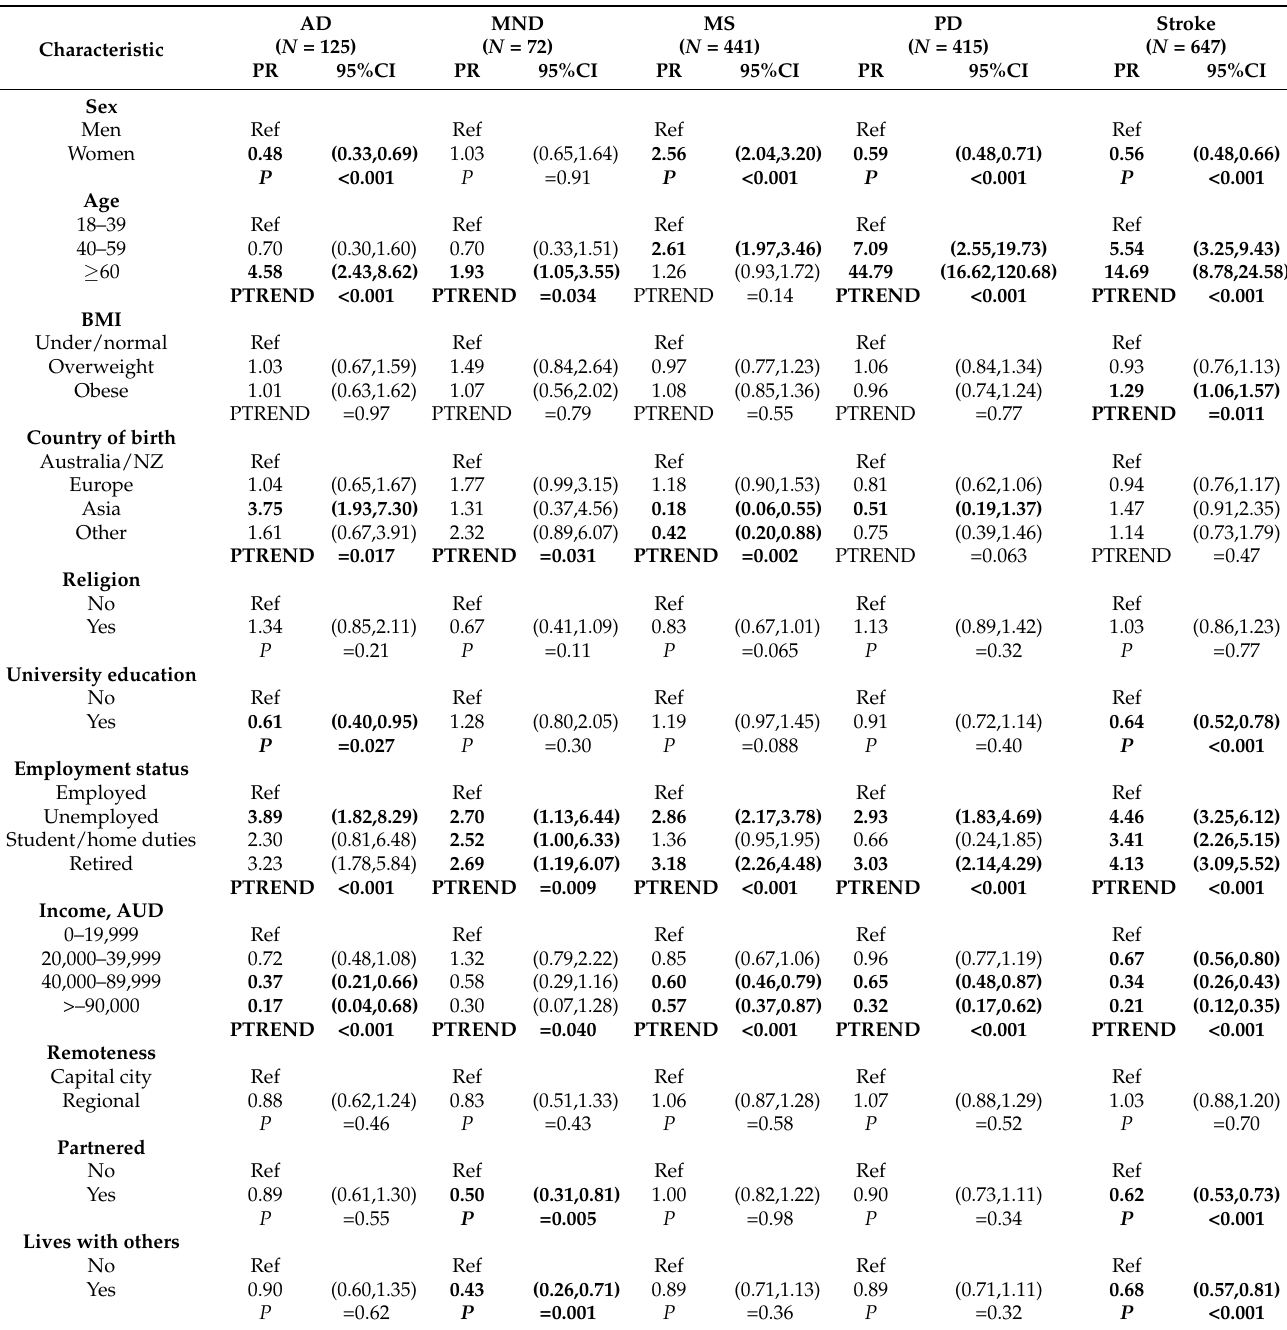
Table 3. Characteristics of neurological disorders referenced to comparator